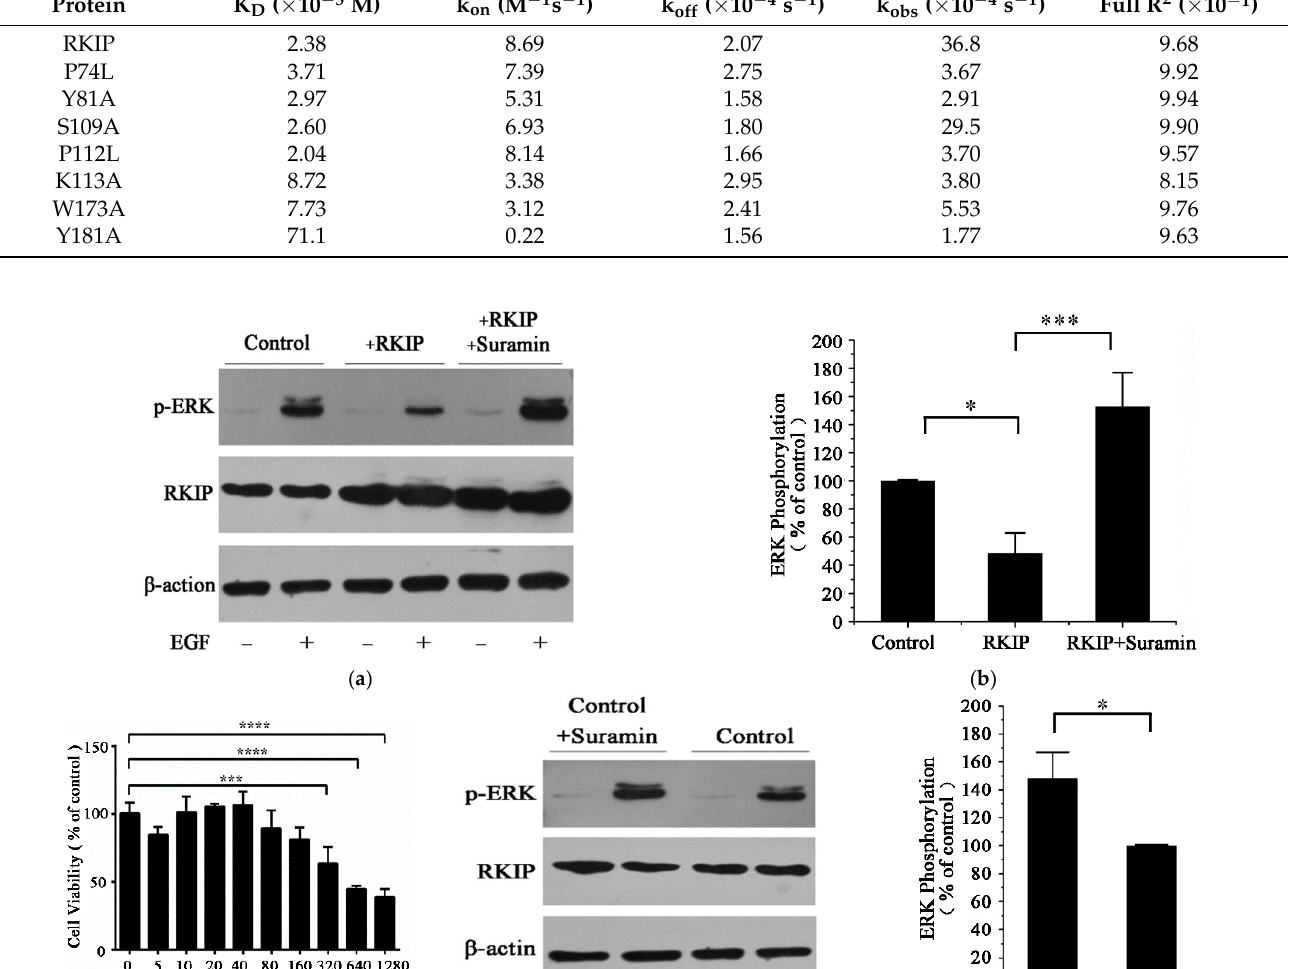
Table 1. BLI-derived kinetic parameters describing the interactions of suramin with hRKIP and its mutants. Protein